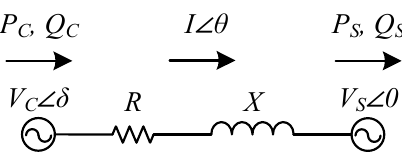
Figure 3. Single-line diagram of the simplified three-phase Figure 3. Single ‐ line diagram of the simplified three ‐ phase system.